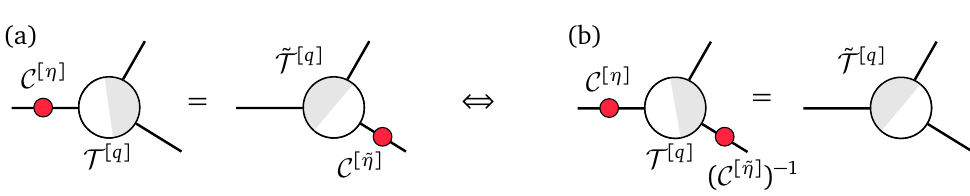
Figure 28: (a) Re-isometrization of a node in the unitary gauge (essentially steps (b) → (c) and (c) → (d) from Fig. 27), achieved by QR decomposition. (b) Formulation of the same transformation in terms of a link-local gauge transformation (see Sec. 1.7), by contracting the respective non-unitary center matrices C [ η ] and ( C [ ˜ η ] ) − 1 (both red) into their adjacent node. However, this is only possible if their (single-sided) inverses exist, i.e. if the bond dimensions equal the matrix